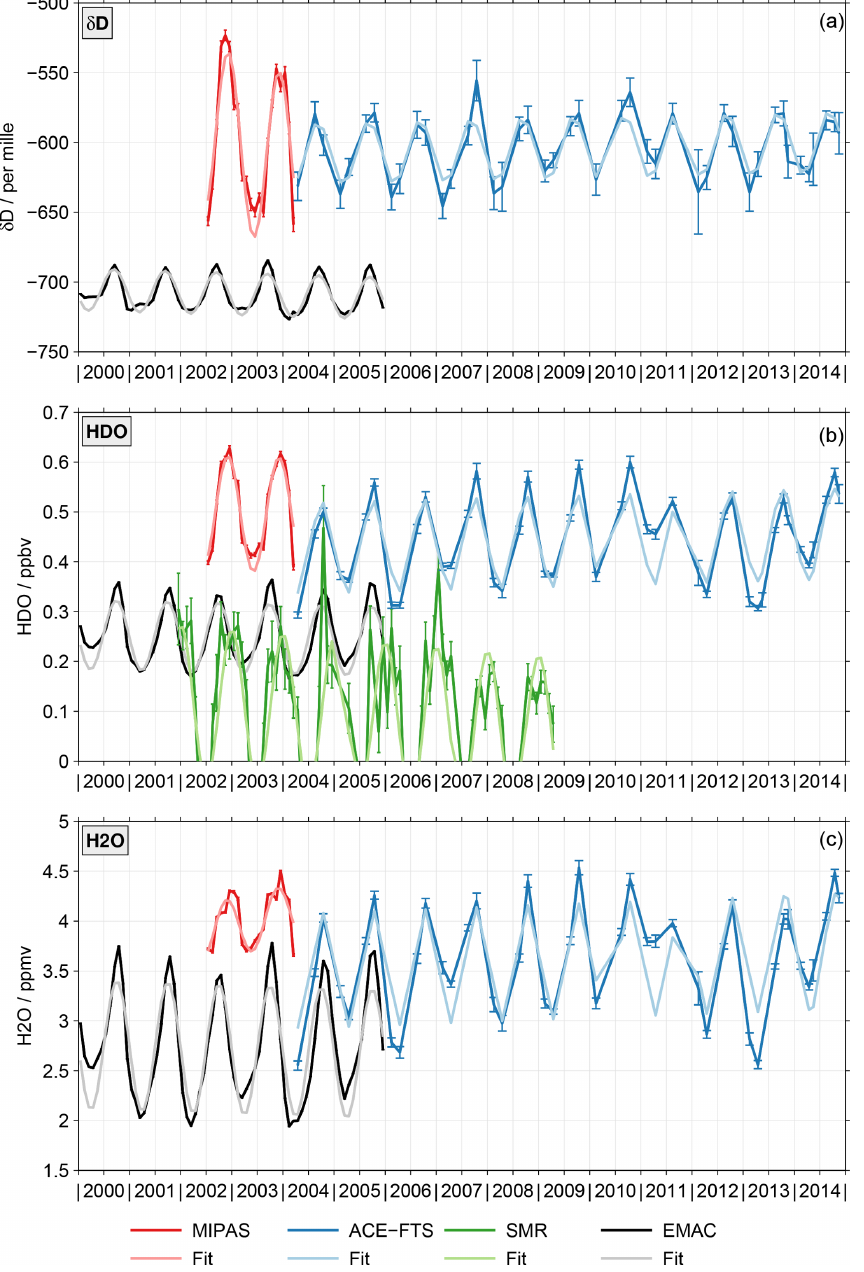
Figure 2. Dark colours: monthly mean time series of δ D (a) , HDO (b) and H 2 O (c) at 70hPa for the different data sets. The error bars represent the standard mean errors. Light colours: the fits of these time series based on the regression model described by Eq.